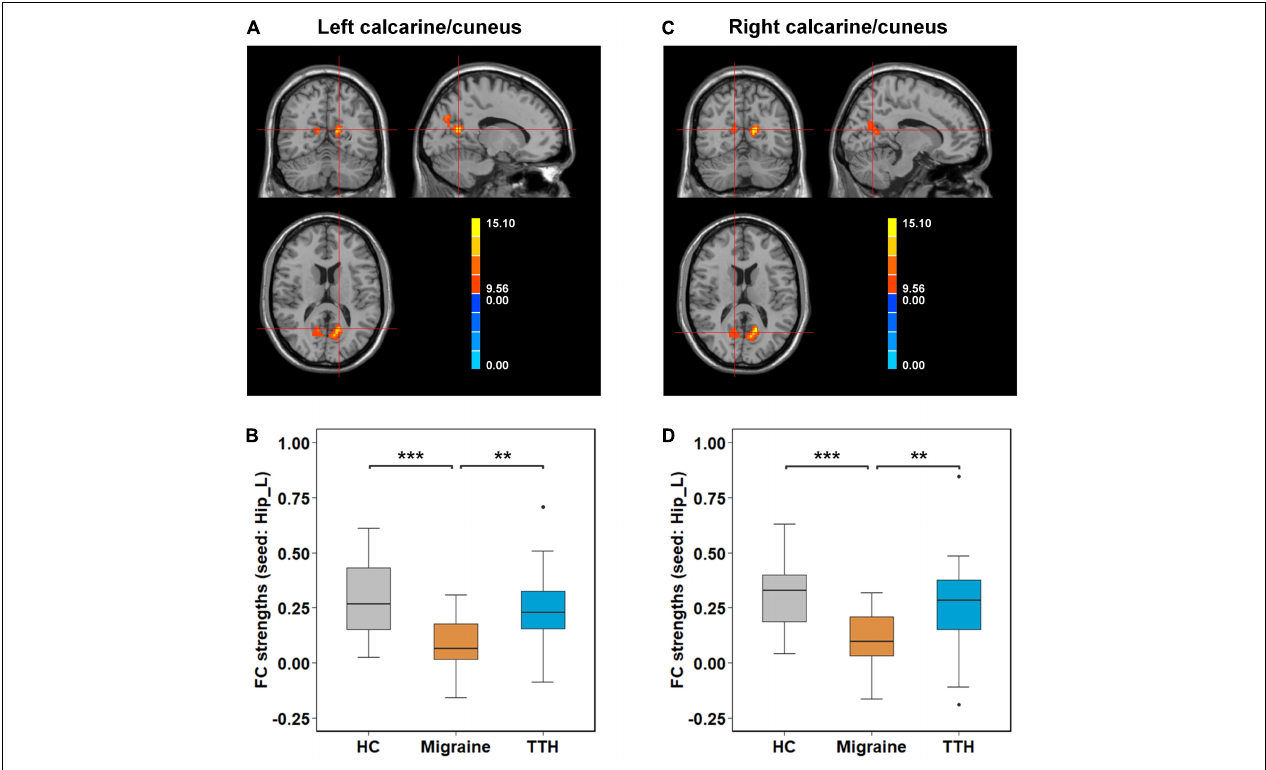
FIGURE 3 | Intergroup differences in rsFC strengths (seed: left hippocampus). Migraineurs showed decreased rsFC of left hippocampus with left calcarine/cuneus (–15,–60, 15) (A,B) and right calcarine/cuneus (12,–63, 15) (C,D) in comparison with HCs and patients with TTH. The pair-wise differences in the significant clusters observed in one-way ANCOVA ( Table 2 ) were tested using post-hoc t -tests. * p -value < 0.05; ** p -value < 0.01; *** p -value < 0.001. rsFC, resting-state functional connectivity; Hip_L, left hippocampus; HCs, healthy controls; TTH, tension-type headache; ANCOVA, analysis of covariance.